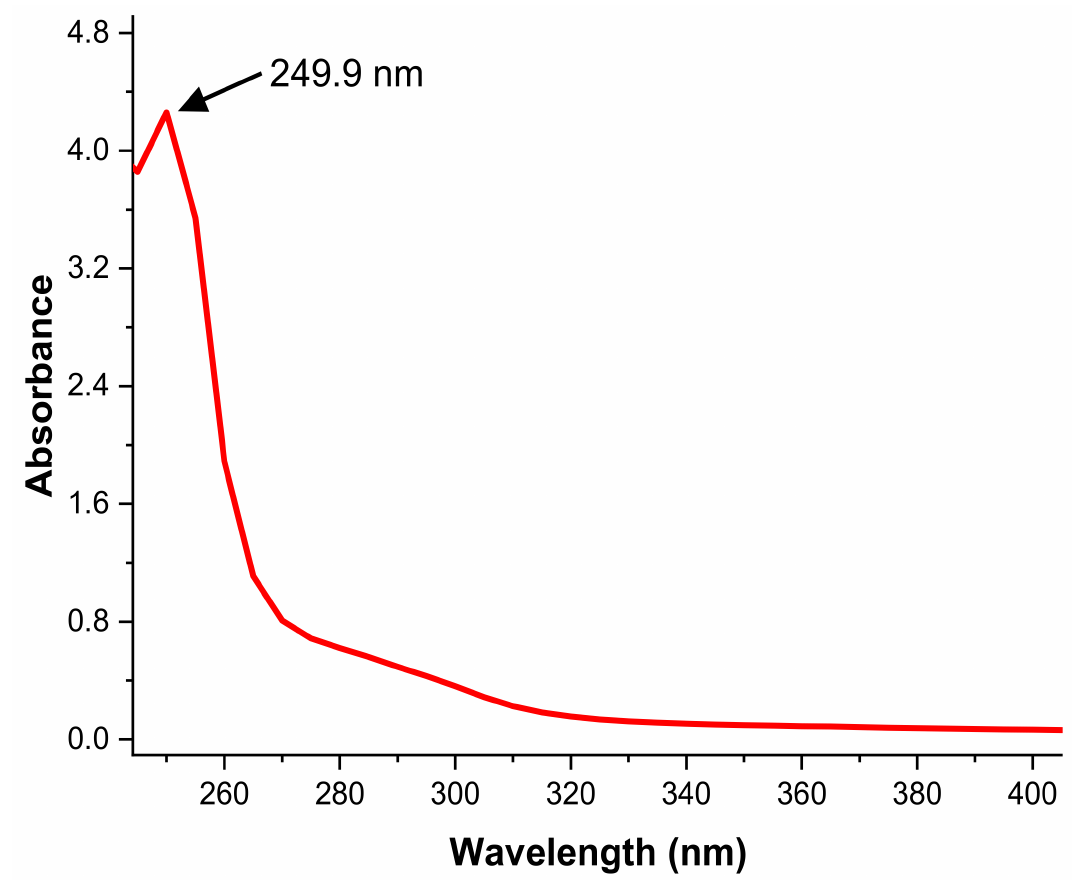
Figure 4. UV-Visible spectra of biosynthesized CuO